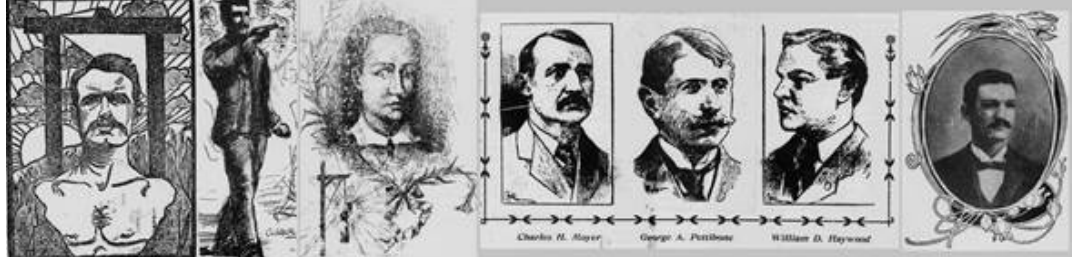
Artwork of varied styles included in the 29 July 1907 special issue on Gaetano Bresci, an anarchist who assassinated King Umberto I of